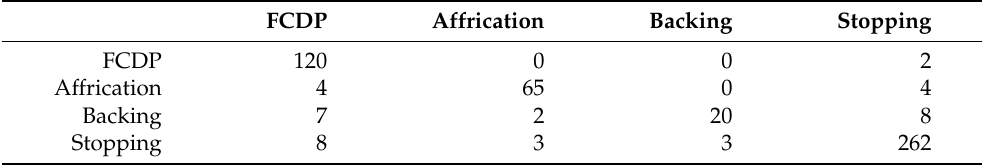
Figure 7. Validation accuracy of single Chinese phrase multi-category classification box plot (Experiment-1). The top and bottom of the box are the interquartile ranges (75th and 25th per- centile) centered around the median value (50th percentile). The whiskers represent the minimum and maximum validation accuracy values. Table 8 presents the results in detail. Table 7. One of the most effective confusion matrices in Experiment 1 when the DenseNet121 model was used. Rows indicate output classes, columns indicate target